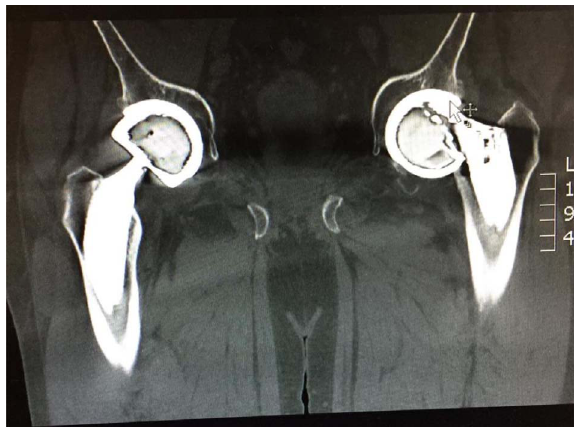
Figure 1. CT scan (Coronal View) showing dislocated femoral head for the trunnion of the femoral neck.